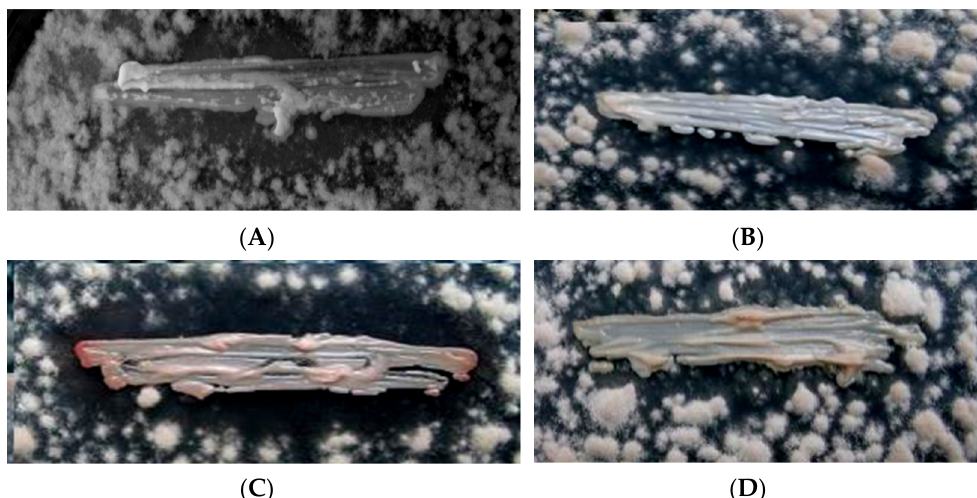
Figure 1. Growth inhibition of Botrytis cinerea by yeasts (yeasts were streaked onto the middle region of the Botrytis cinerea lawn and were cultured on PDA medium, at room temperature, and photographed after 7 days). ( A ): Pichia kudriavzevii (11-460), ( B ): Wickerhamomyces anomalus (11-502), ( C ): Metschnikowia fructicola (11-579), ( D ): Saccharomyces cerevisiae (11-481). (11-460, 11-502, 11-579, 11-481: collection number of the strains in the collection of Department of Genetics and Applied Microbiology) (photos were taken by Enik ő Horváth).